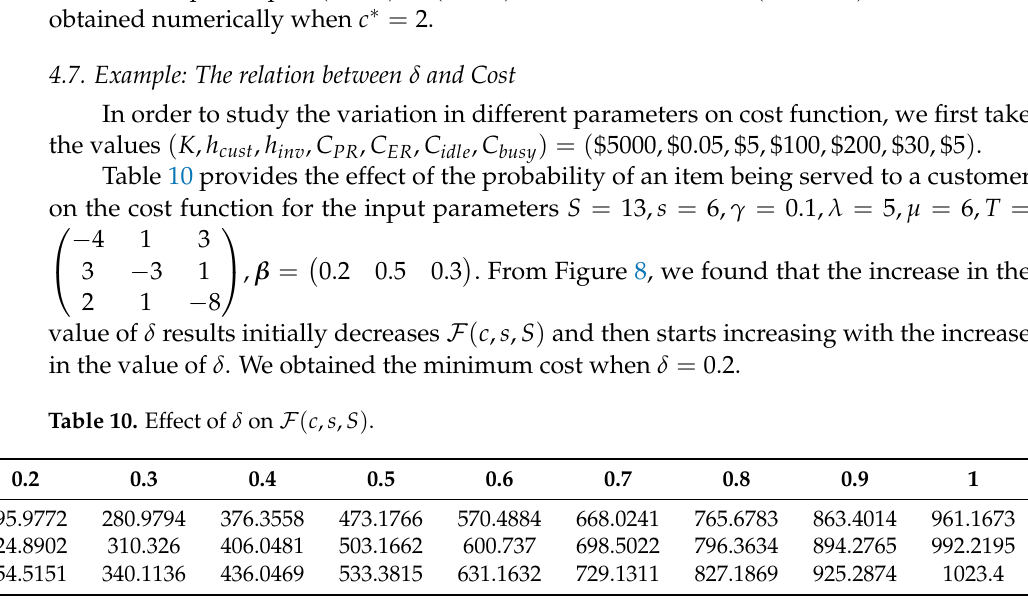
Table 10: Effect of δ on